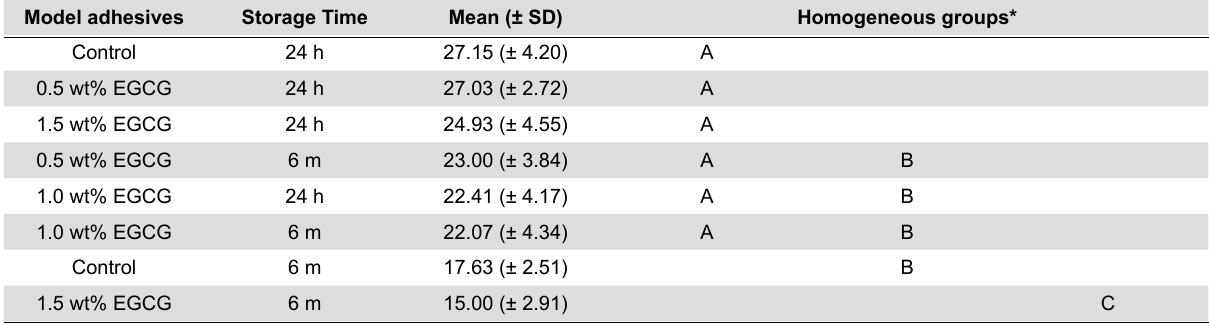
Table 1- Mean values (± standard deviation) of bond strength and the results of Tukey test for adhesives and storage